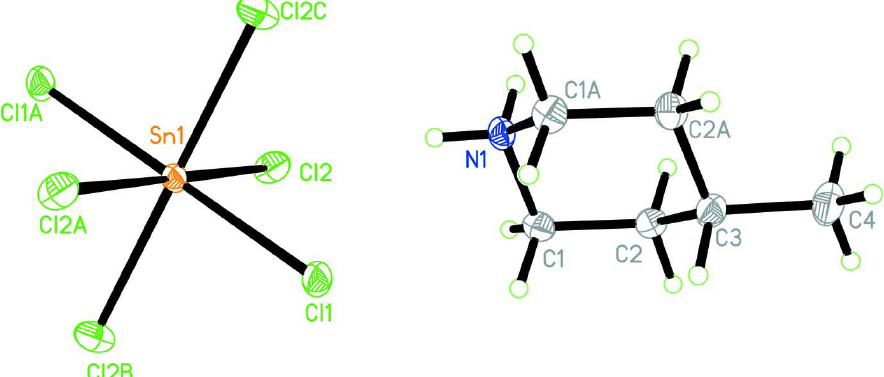
Structure of (I) with displacement ellipsoids drawn at the 50% probability level. The unlabelled atoms of the 4-methyl- piperidinium cation are symmetry related (symmetry code x , y , - z ). The unlabelled Cl atoms are symmetry related to Cl1 (symmetry code - x , 2 - y , - z ) and Cl2 (symmetry codes - x , 2 - y , - z ; - x , 2 - y , z ; x , y , - z